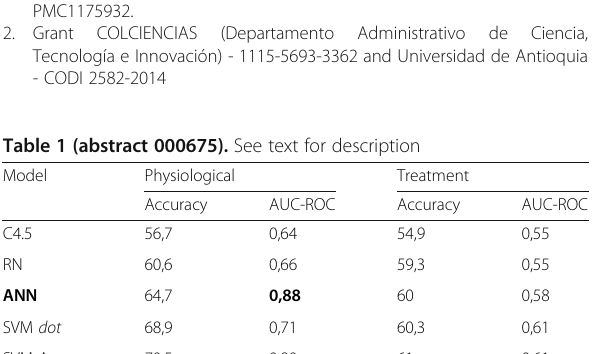
T1 Fig. 1 (abstract 000584). See text for